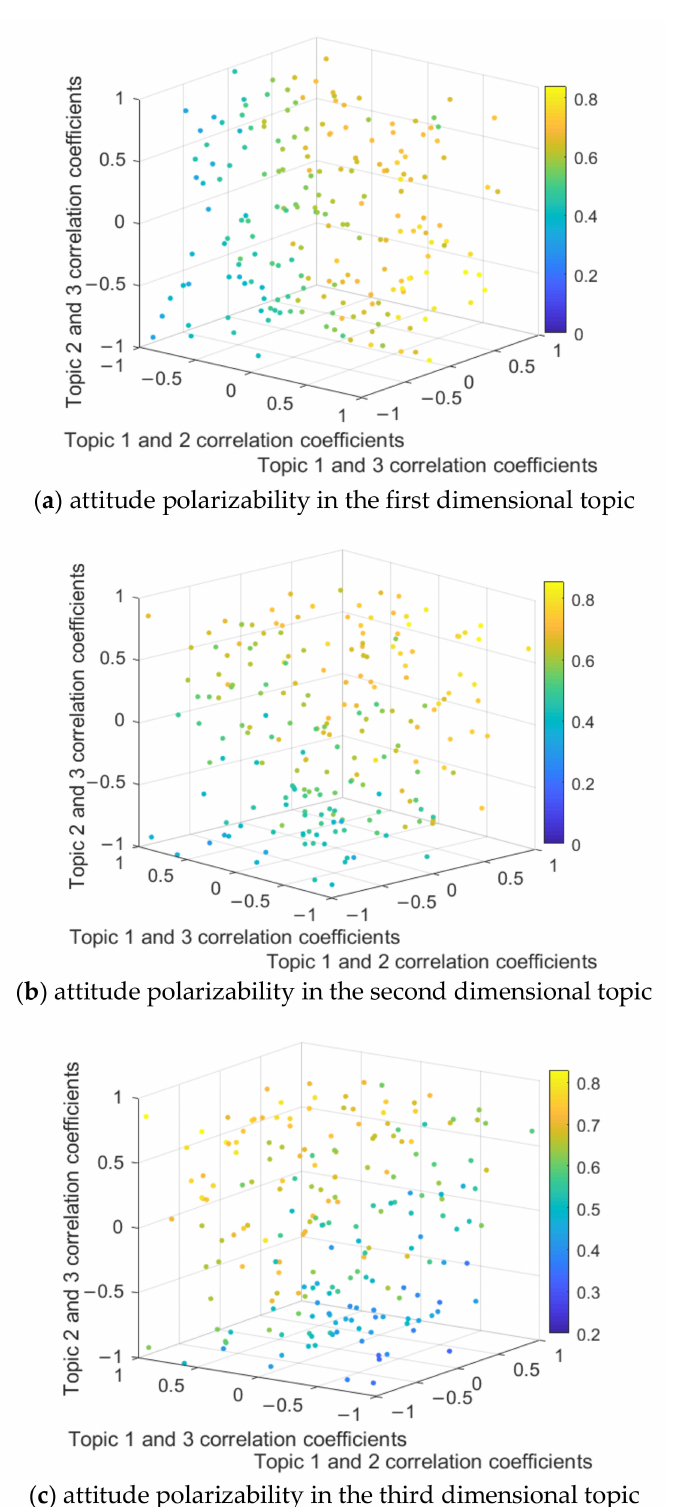
Figure 15. Attitude polarizability when the topic correlation coefficients are randomly